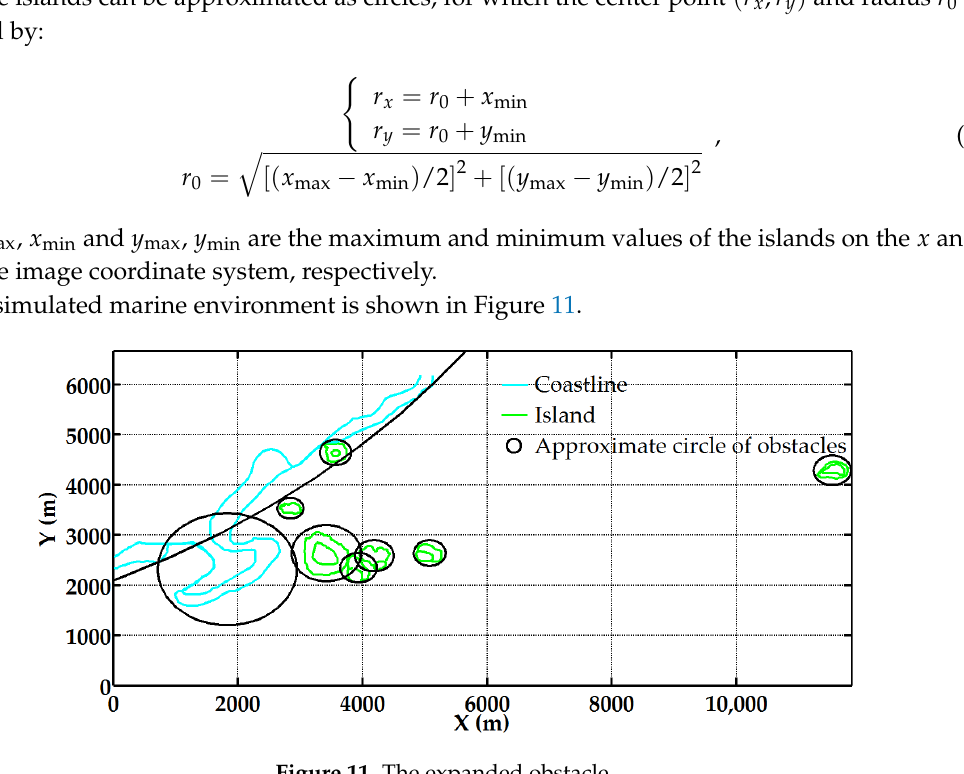
Figure 11. The expanded obstacle.